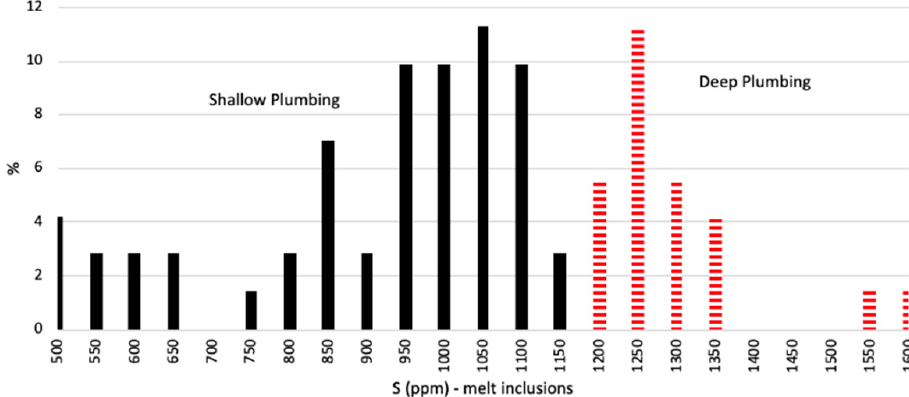
Figure 8. Petrological analysis of sulfur in melt inclusions at Piton de la Fournaise from 2009 to 2015 [13,38]. Inclusions having a sulfur content of ca. 1050 ppm are considered to come from the sea level reservoir. Those that have a higher sulfur content (>1150 ppm) are related to deeper mafic inputs, while partly degassed and shallow seated magmas are recorded by S contents <1000 ppm.